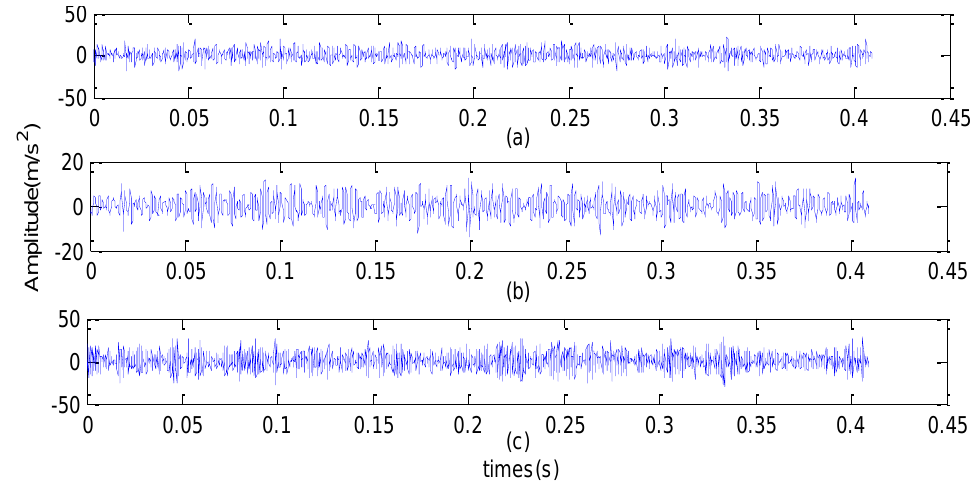
Figure 8. The time domain signals obtained at 1:00 on September 1st, 2006 through wavelet lifting analysis. Approximation signal and detail signal after decomposition through wavelet lifting at level 2. (a) the approximation coefficient c 1 ; (b) the approximation coefficient c 2 ; (c) the detail coefficient d 2 .